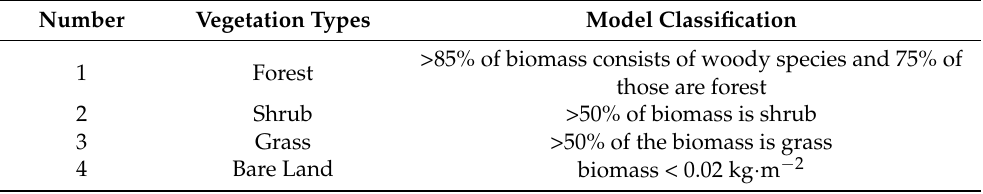
Table 1. Classification of vegetation types based on the LPJ-GUESS